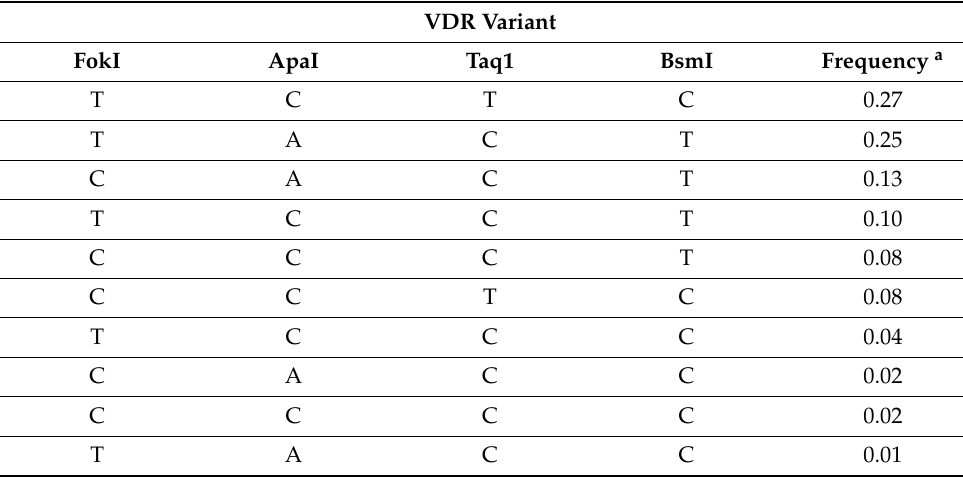
Table 4. Frequency of VDR FoxI , Apa1 , Taq1 , and BsmI haplotypes among diabetic